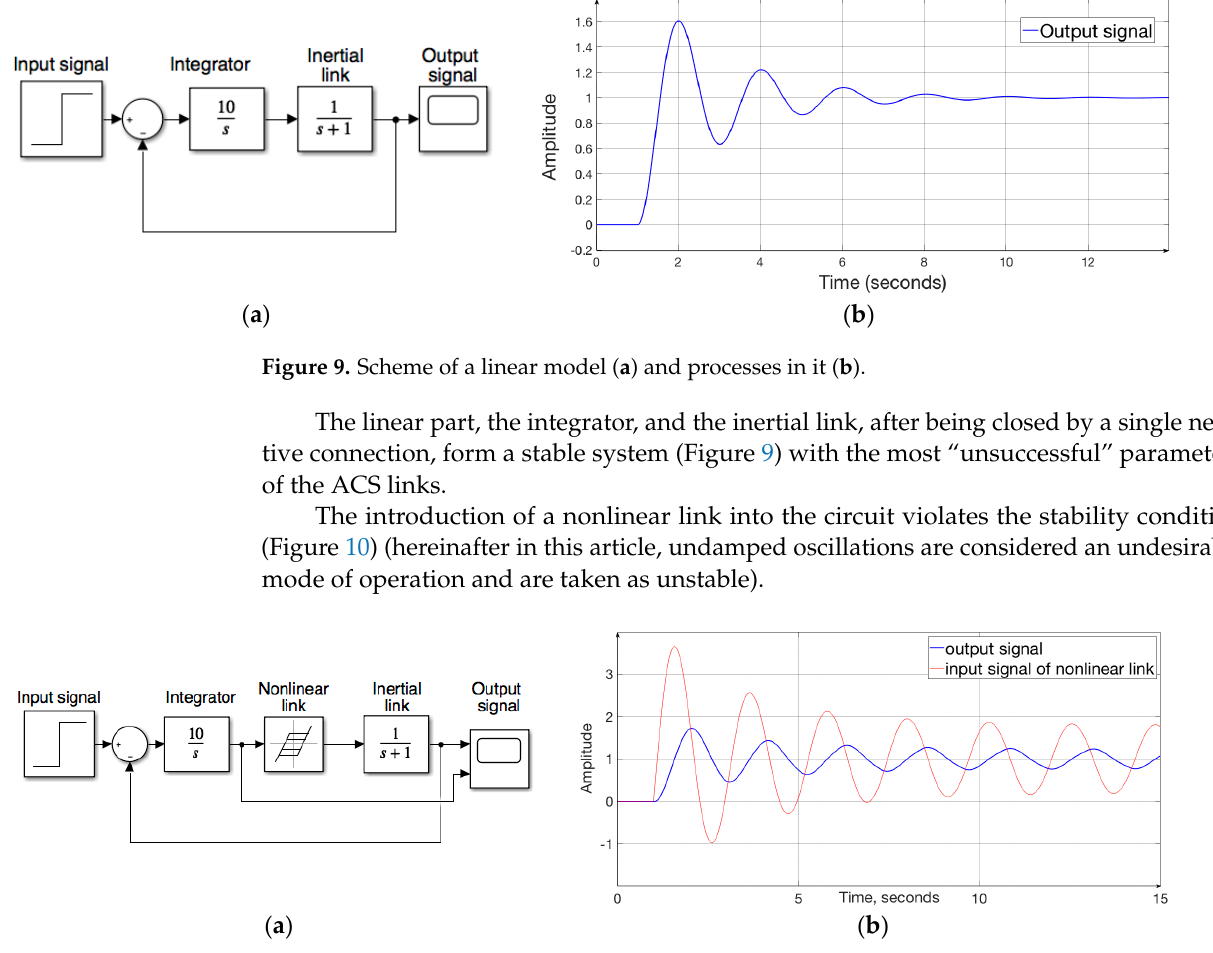
Figure 10. Scheme of the ACS model with nonlinearity ( a ) and processes in it ( b ).